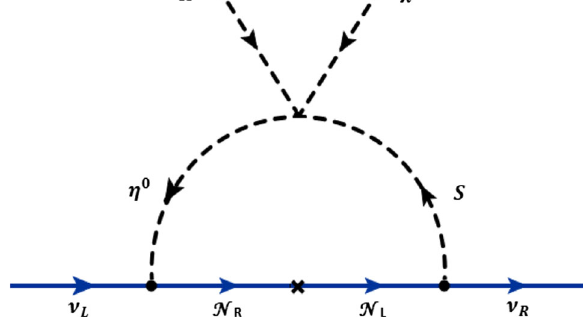
Fig. 2 Representative Feynman diagram for the simplest one-loop Dirac neutrino mass